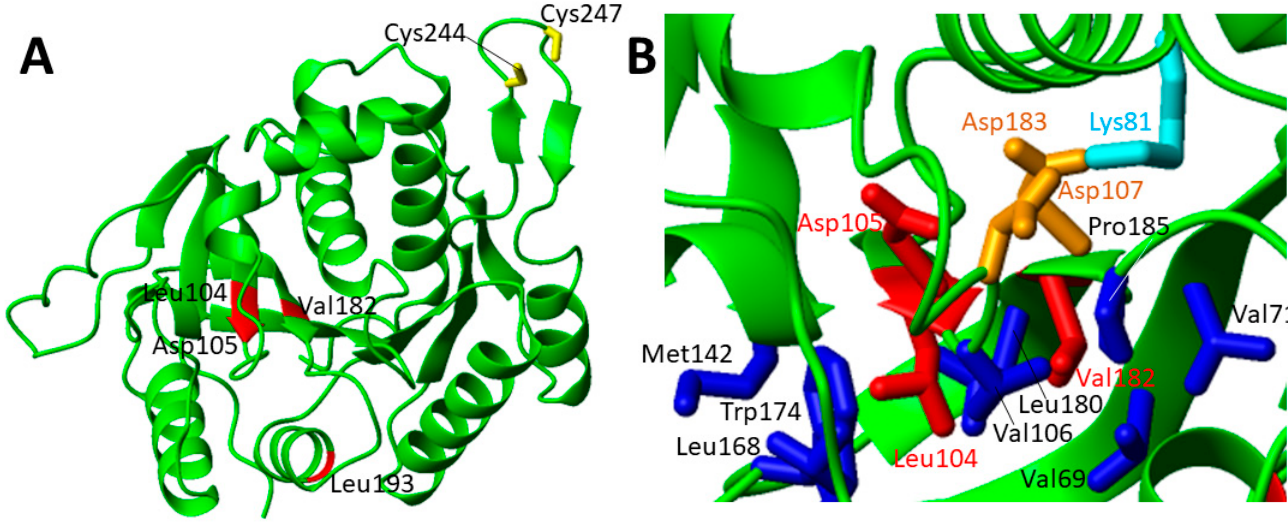
Figure 9. Pathogenic missense mutations mapped on the structural model of human IND1 obtained by AlphaFold2. ( A ) The backbone of the residues involved in pathogenic missense mutations of IND1 are colored in red on the ribbon structure of IND1, and the sidechains of the two conserved cluster coordinating Cys residues are shown in yellow. ( B ) The sidechains of Asp105, Leu104 and Val182 are shown in red. The Asp and Lys residues involved in the electrostatic interactions with Asp105 are shown in orange and cyan, respectively. The sidechains of the hydrophobic residues close in space to Leu104 and Val182 are shown in blue.